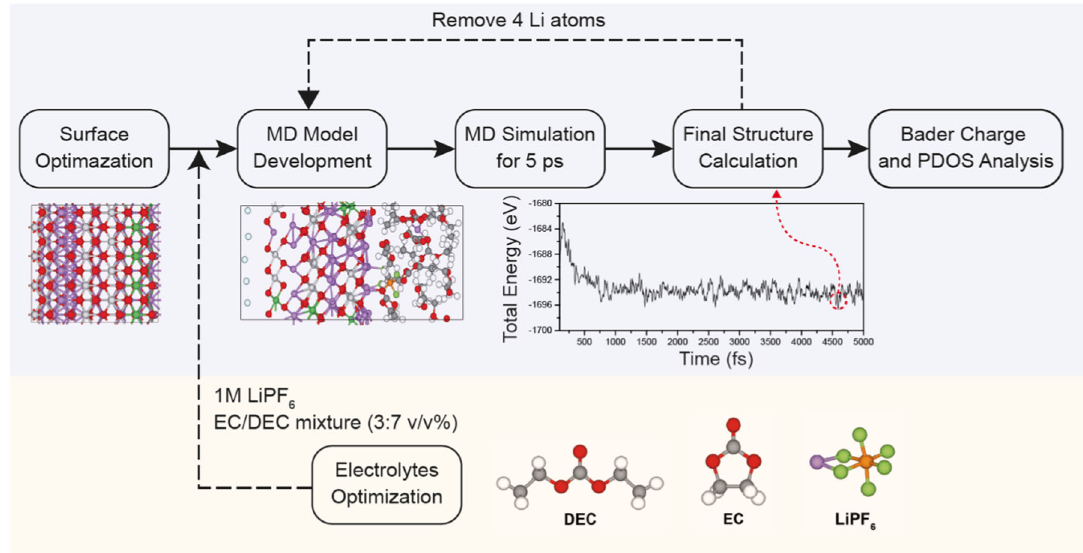
Fig. 8 Flow chart of the development of AIMD simulation model for the delithiation process in the pristine and S-substituted LNMO (003) surface. The fi ve steps include 1. Surface optimization from the p (4 × 1) supercell of the LNMO (003) surface, 2. The development of AIMD models with electrolytes, 3. The AIMD simulations equilibrated at 400 K in a canonical ensemble (NVT) for a total time of 5 ps with a time interval of 1 fs, 4. The optimization of LNMO structures according to the lowest total energy over the fi nal half of the trajectory, and 5. The analysis of Bader charge and projected density of states